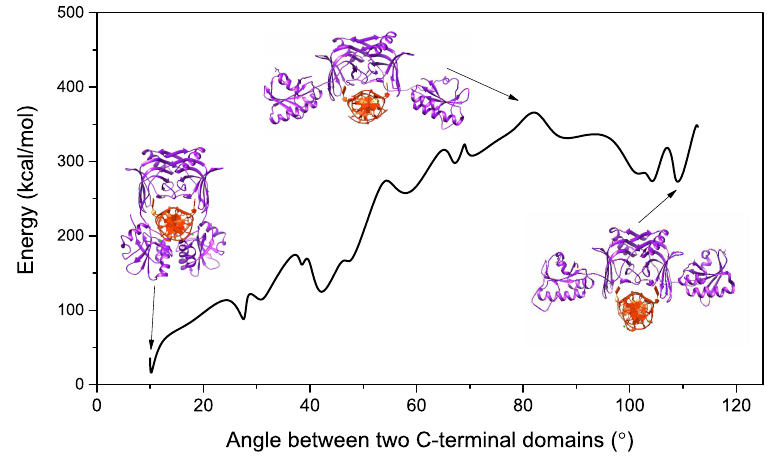
Figure 1. The relative energy of the EndoMS/NucS-dsDNA system as a function of the conformational co-ordinate (the angle between the two C-terminal domains of